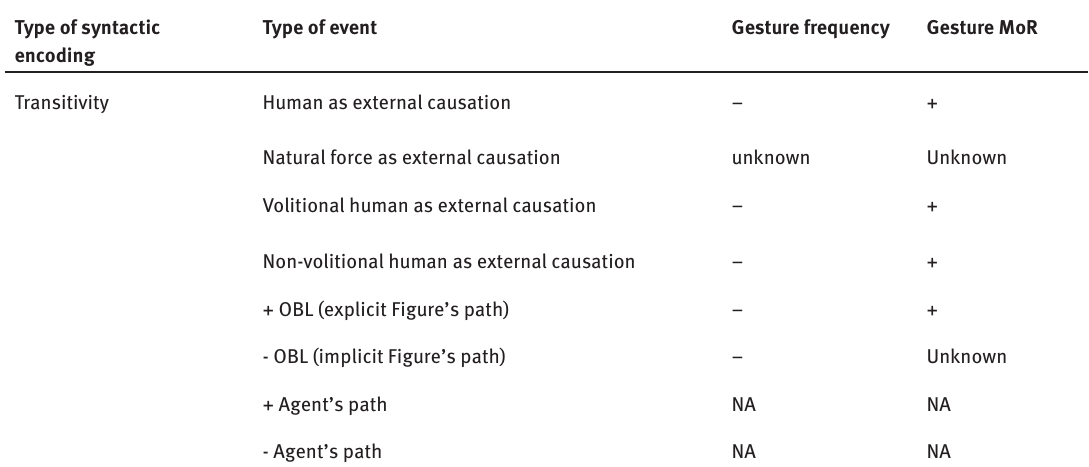
Table 11. Relations found between transitivity and gesture in various types of events